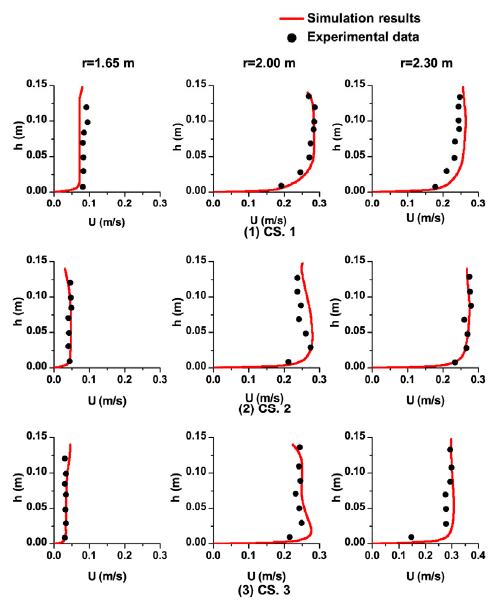
Figure 2. ( a ) The schematic of a U ‐ shape open ‐ channel with an emergent rigid vegetation region on the convex bank and the detailed view of the vegetation region (units: m); ( b ) The local refined calculating mesh.